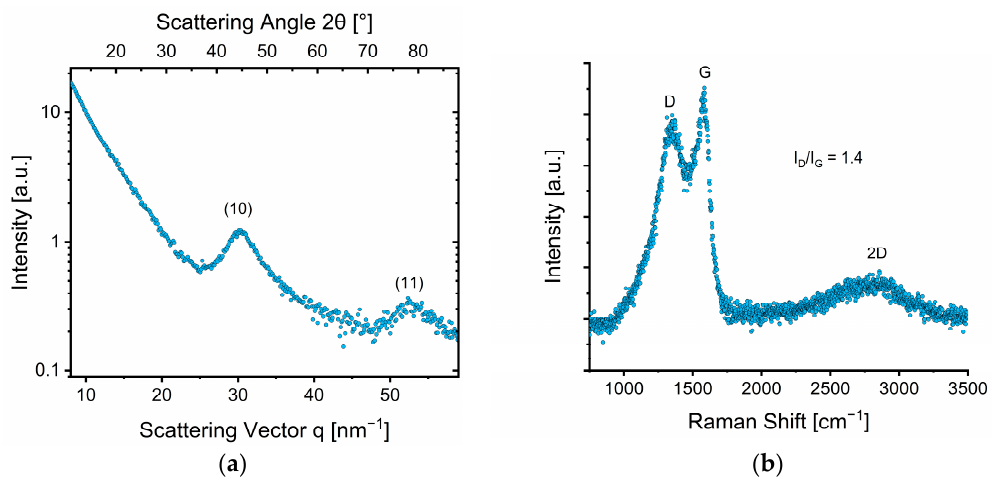
Figure 4. ( a ) X-ray diffractogram and ( b ) Raman spectrum of AC—CSS.